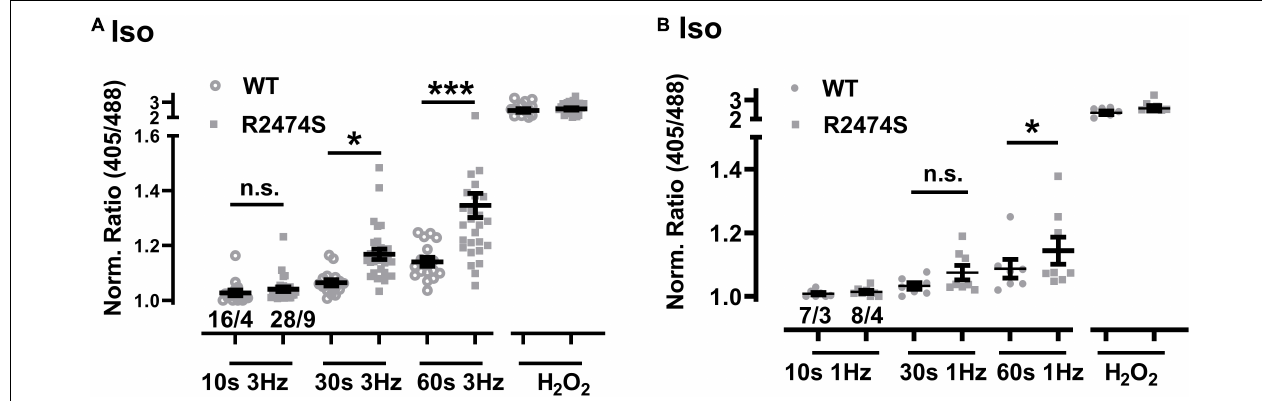
FIGURE 7 | Comparison of the increased mitochondrial oxidation in RyR2-WT control vs. RyR2-R2474S dTG-cardiomyocytes following β -adrenergic stimulation. (A) Dot plot showing the individual and mean values ± SEM of the normalized I405/I488 nm ratio values after 3 Hz beating for 10, 30, and 60 s in the presence of isoproterenol (100 nM). Open circles and closed squares reflect the values of the single experiments from RyR2-WT control and Ryr2-R2474S dTG mice, respectively. Cell/heart numbers are indicated. Unpaired one-way ANOVA with Tukey’s post-test. *** P < 0.001; * P = 0.04; (B) Dot blot showing individual and mean values ± SEM of normalized ratio values obtained after EFS at 1 Hz with a 10, 30, and 60 s duration in the presence of isoproterenol (100 nM). Open circles and closed squares reflect the values of the single experiments from RyR2-WT control and Ryr2-R2474S dTG mice, respectively. Numbers indicate the number of cells/number of mice used. Statistical analysis was performed by unpaired one-way ANOVA with Tukey’s post-test. * P < 0.02; n.s., non-significant.